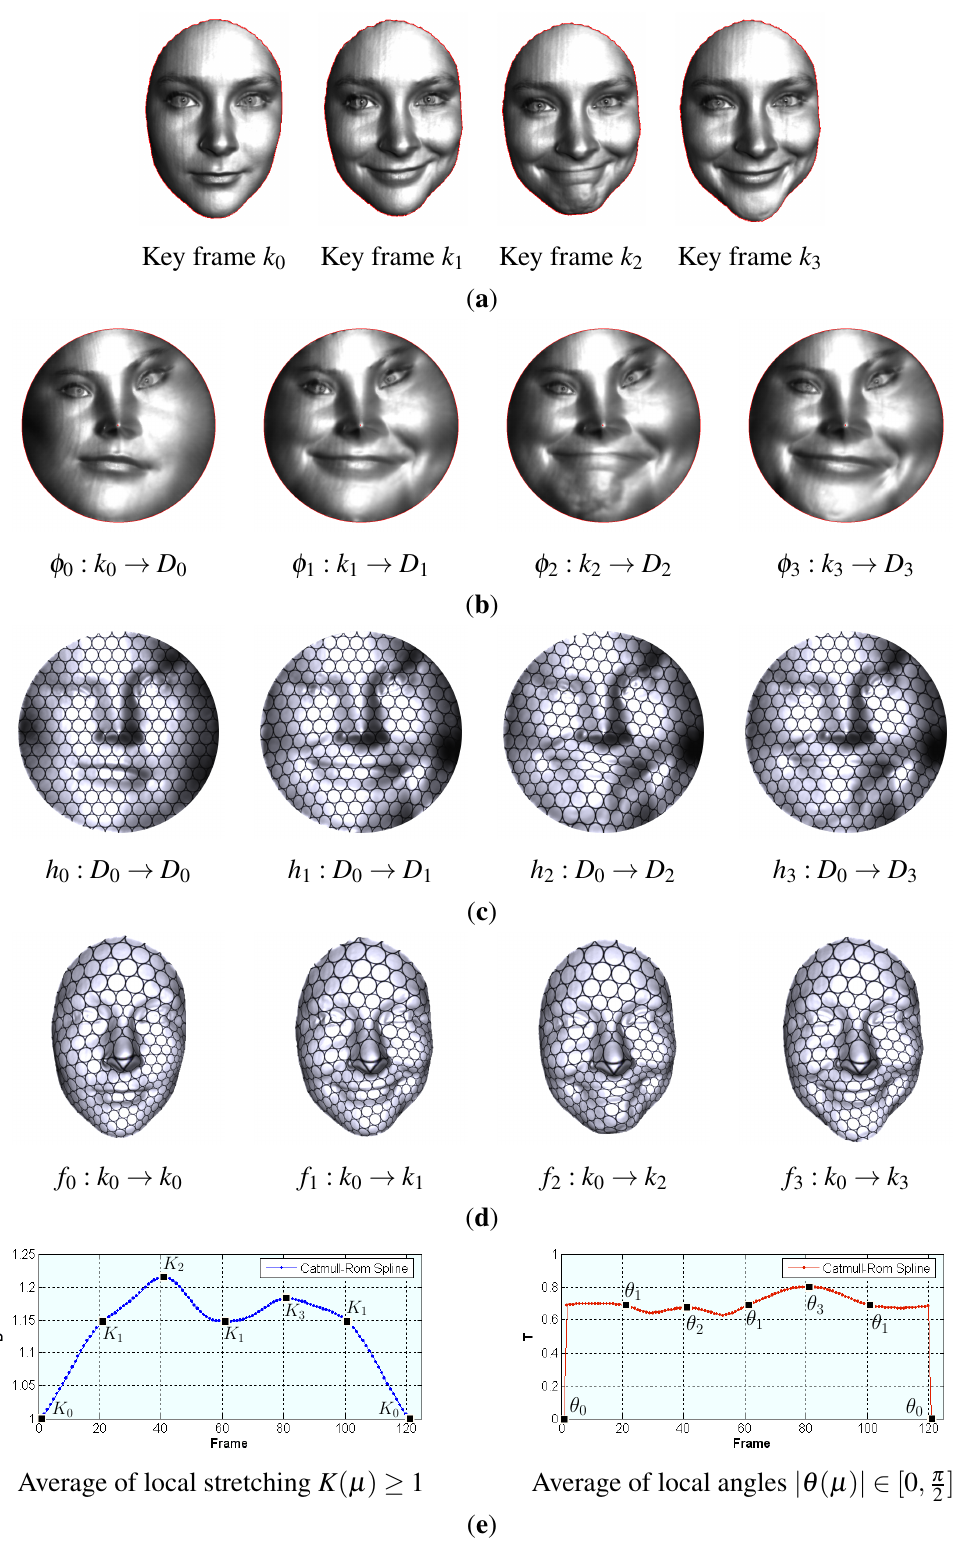
Figure 5. Diffeomorphism spline from the key frames of a 3D facial expression video. ( a ) Key frames; ( b ) conformal mappings to the unit disk; ( c ) consistent texture mappings on 2D conformal images; ( d ) consistent texture mappings on 3D original surfaces; ( e ) Catmull–Rom spline for diffeomorphisms of 7 key frames, k from k 0